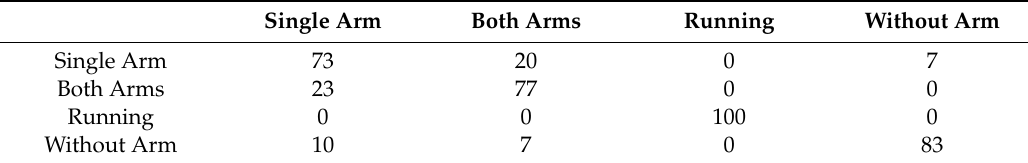
Table 4. Confusion matrix results of